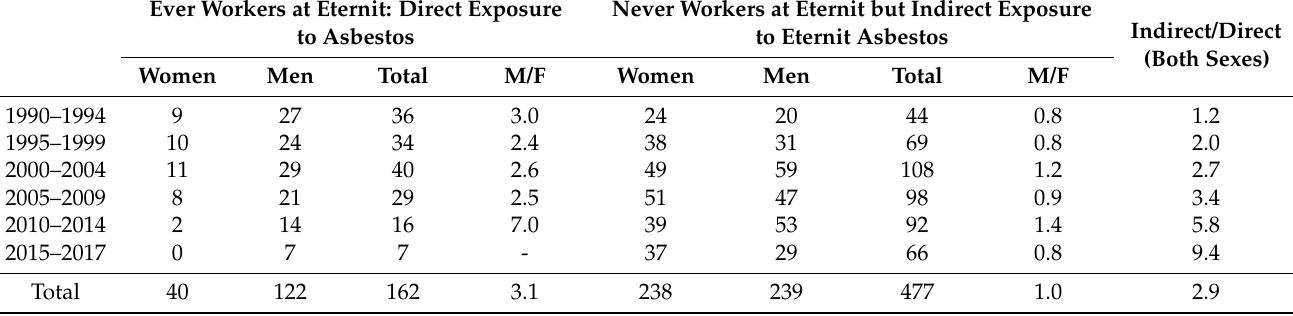
Table 1. Absolute numbers of incident mesothelioma cases in Casale Monferrato population broken down by sex and by period of diagnosis. Incidence in residents ever working in Eternit plant is compared to incidence in residents never working at—but indirectly exposed to—Eternit asbestos (see text for